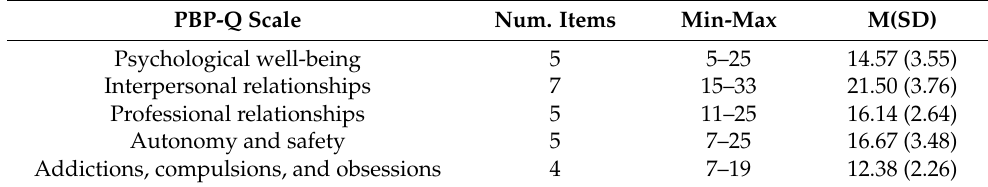
Table 2. Descriptive statistic of the Prosthetic–Bionic Paradigm Questionnaire (PBP-Q; n = 118) scales. PBP-Q